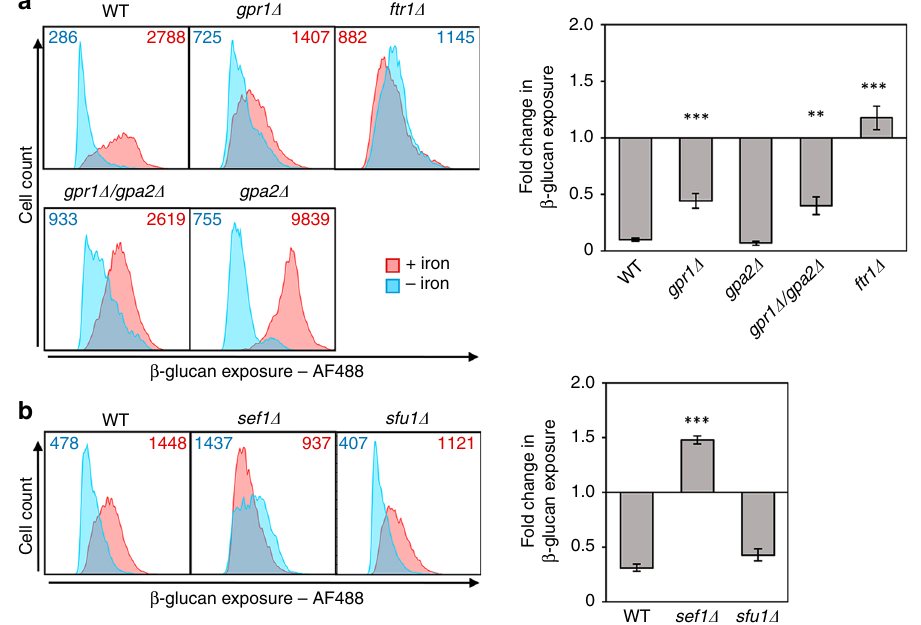
Fig. 8 Iron-limitation-induced β -glucan masking depends on Ftr1 and Sef1. C. albicans strains were exposed to iron replete (pink) or iron-deplete conditions (cyan), fi xed and stained with Fc-dectin-1. Their levels of β -glucan exposure were quanti fi ed by cytometry, and the median fl uorescence intensities (MFIs) for the iron replete and deplete cell populations are shown. The fold changes in β -glucan exposure are shown in the right-hand panels. a Contributions of receptors to iron-limitation-induced β -glucan masking: WT, wild type, SC5314; gpr1 Δ , LR2; gpa2 Δ , NM6; gpr1 Δ gpa2 Δ , NM23; ftr1 Δ (Supplementary Table 1). b Contributions of iron regulators: WT, wild type, SN152; sef1 Δ ; sfu1 Δ (Supplementary Table 1). Means and standard deviations from three independent replicate experiments are shown, and the data were analysed using ANOVA with Tukey ’ s multiple comparison test: * p < 0.05; ** p < 0.01; *** p < 0.001. Source data are provided as a Source Data fi